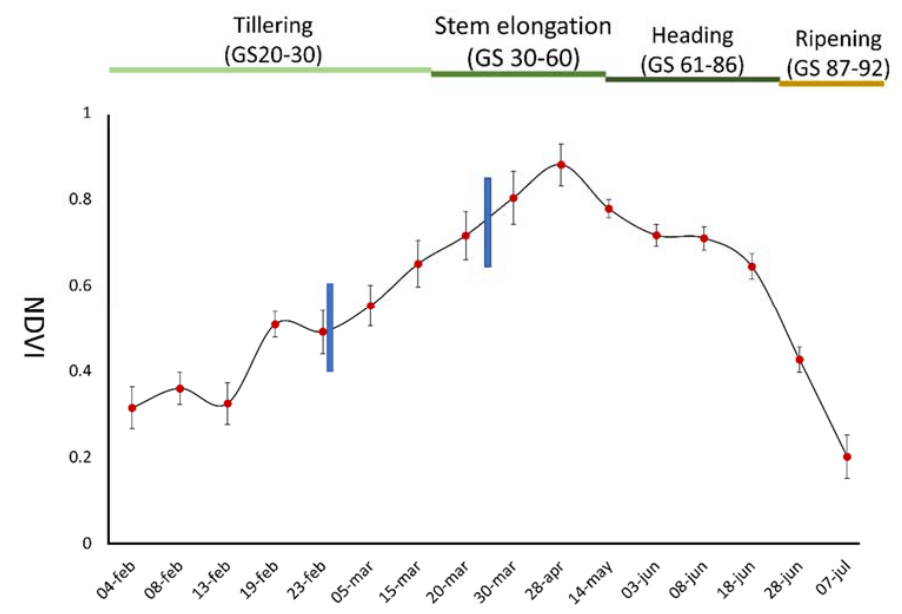
Figure 5. Seasonal evolution of NDVI across the 13 studied plots in year 2019. Red dots are the mean value of NDVI, calculated using the 13 mean plot NDVI values, and error bars represent the standard deviation. In the figure, the onset and duration of the four key phenological stages are represented. The vertical blue lines represent the two dates when ANC fertilizer was applied, 26 February and 25 March.